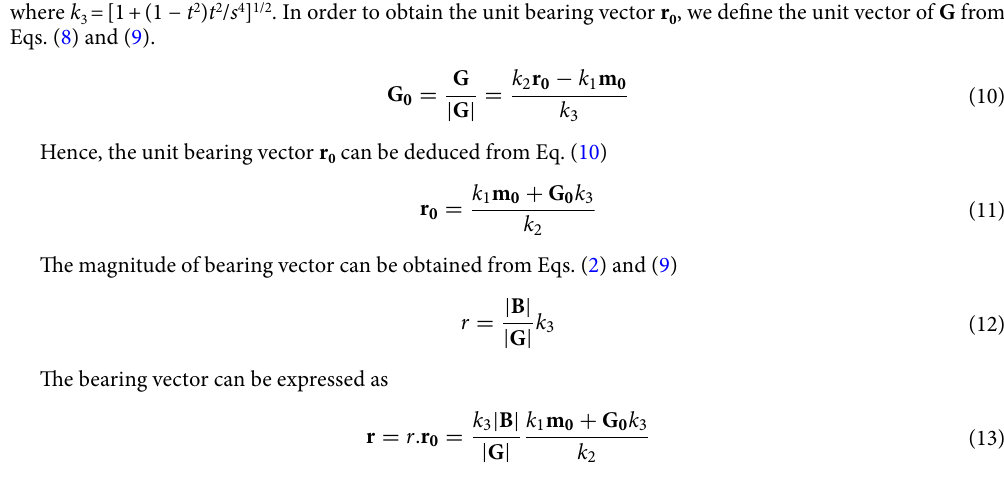
Initialization Total field | B | and its gradients data G measured by a scalar magnetometer array are used to calculated the initial value of r 0 and r with Eq. (5) and Eq. (6).respectively while convergence condition is not met do Calculate s and t with r 0 and m 0 ; Calculate k 1 , k 2 and k 3 with s and t ;